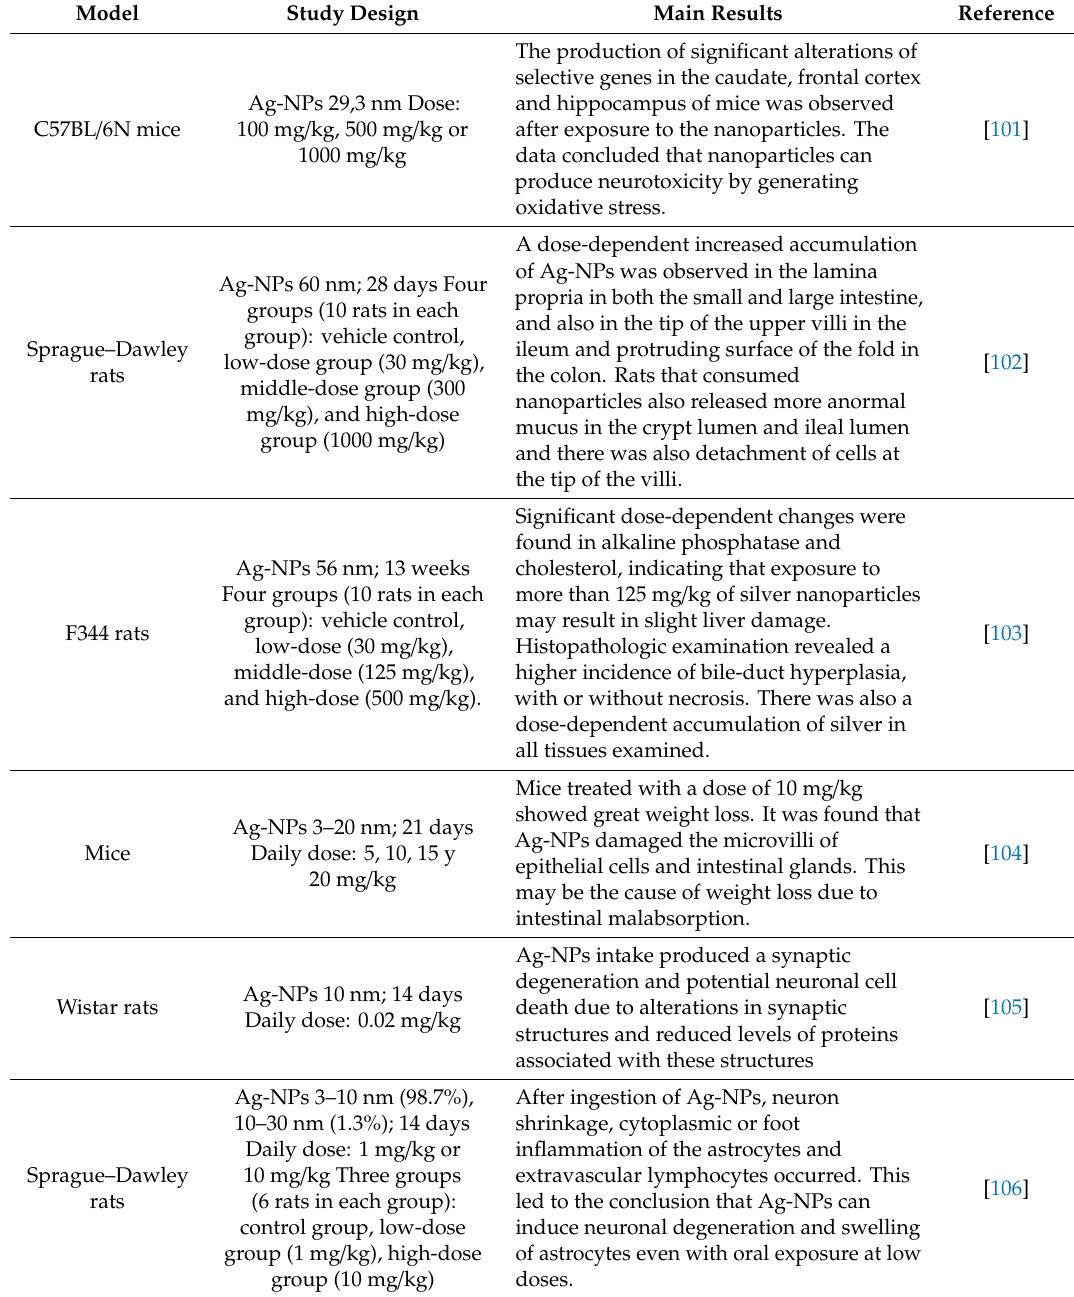
Table 4. In vivo studies regarding silver nanoparticles e ff ects at gut level and microbiota, organs and